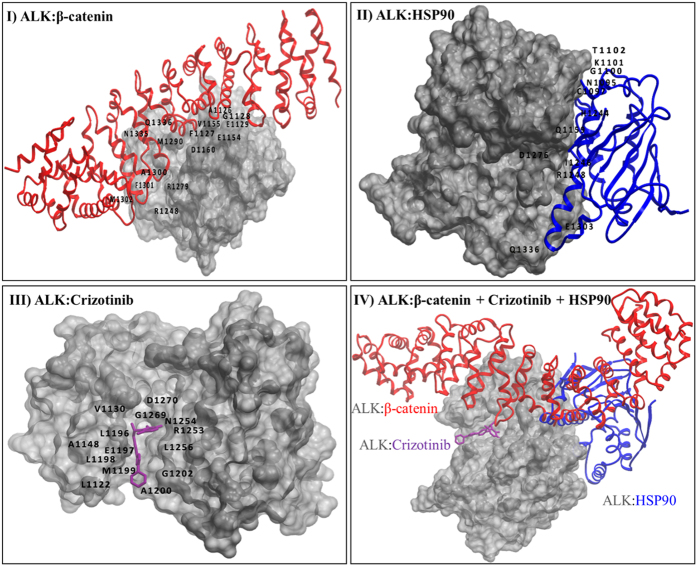
Computational analysis of ALK-β-catenin interaction supports the observed blockage of Crizotinib—ALK binding.(I) β-catenin was predicted to interact with 15 ALK residues (A1126, F1127, G1128, E1129, E1154, V1155, D1160, R1248, R1279, M1290, A1300, F1301, M1302, N1335 and Q1336). (II) HSP90 was predicted to interact with 12 ALK residues (N1095, C1097, G1100, K1101, T1102, Q1159, H1244, I1246, R1248, D1276, E1303, and Q1336). (III) Crizotinib was reported to bind to 14 ALK residues (L1122, V1130, A1148, L1196, E1197, L1198, M1199, A1200, G1202, R1253, N1254, L1256, G1269, and D1270). (IV) Interaction of ALK with β-catenin, Crizotinib and HSP90.